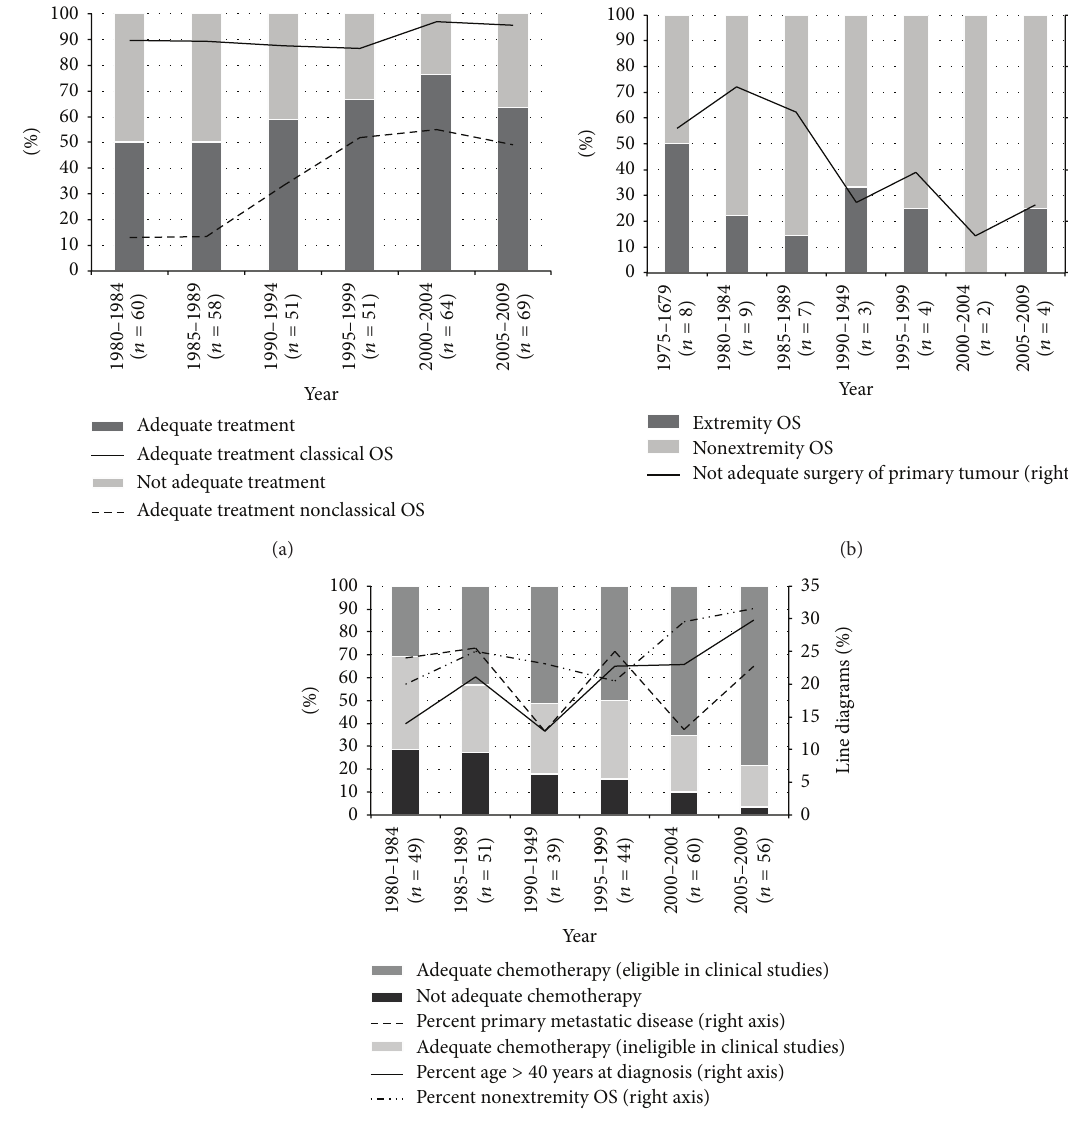
Figure 2: Time trends in distribution of osteosarcoma (OS) patients according to different subgroups: adequate versus not adequate primary treatment (both surgery and chemotherapy), including the percentage of adequate treatment among classical and nonclassical OS (a). The distribution of not adequate primary surgery among extremity versus nonextremity OS (b). Adequate versus not adequate chemotherapy. The percentage of patients > 40 years of age at diagnosis, primary metastatic disease, and nonextremity tumour that received chemotherapy